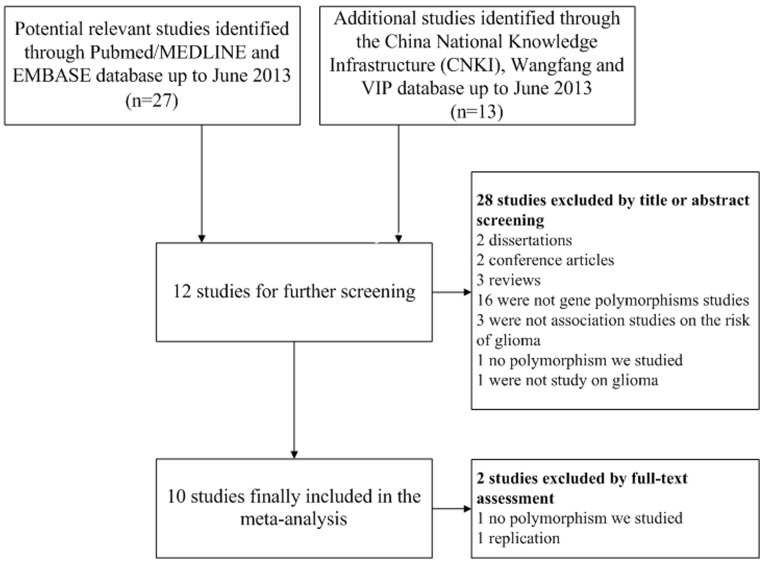
Flow chart of study selection.